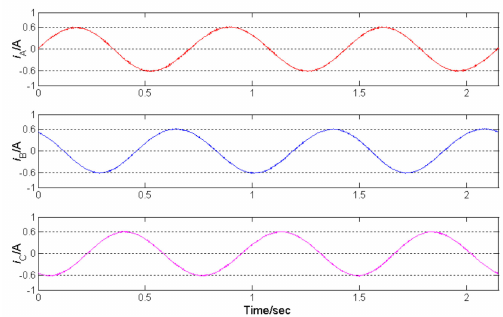
Figure 8. Current control results of i d = 0 control.